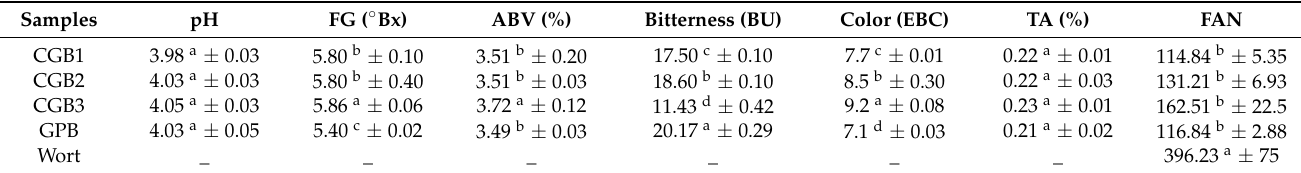
Table 1. Physicochemical properties of Chlorella